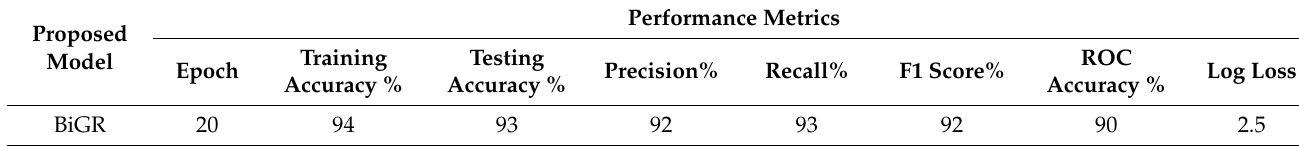
Table 9. The proposed BiGR model results in evaluations with hyperparameter tuning.